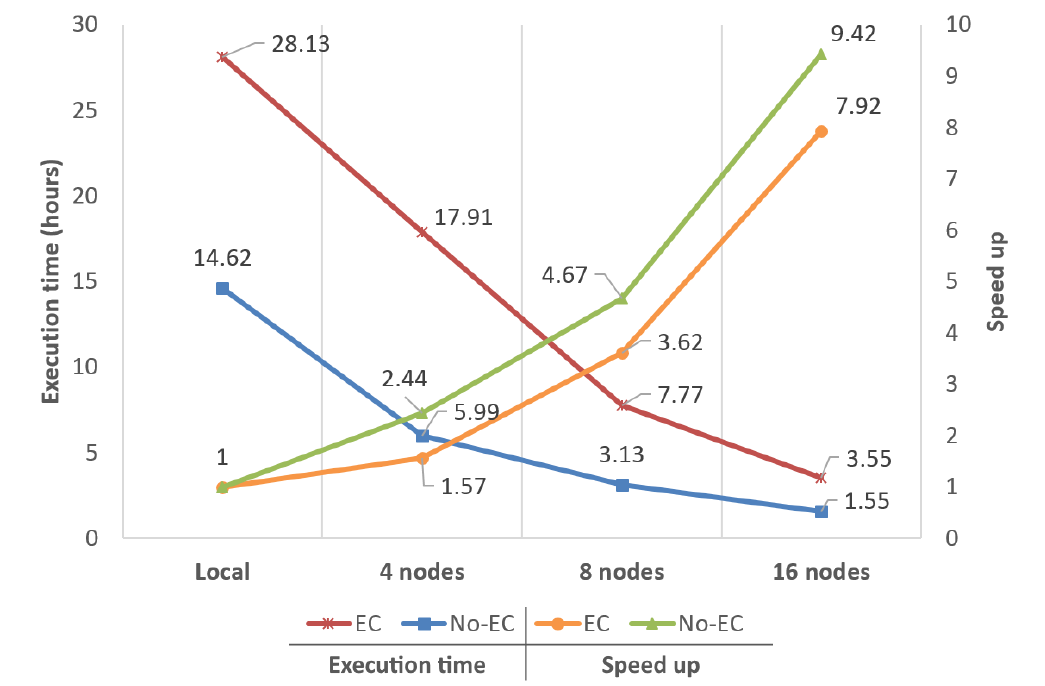
Figure 6. Performance analysis and scalability comparison using dataset D0 (1600 × 1600).